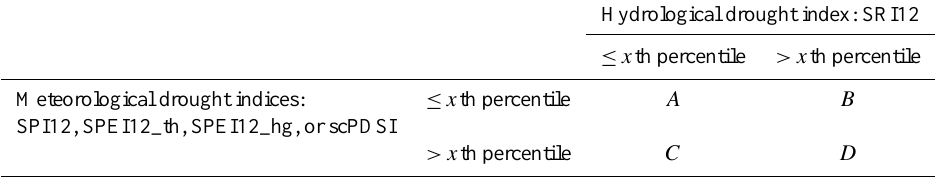
Table 4. Schematic of the 2 × 2 contingency table used to assess the ability of the meteorological indices to detect a hydrological drought event: A denotes the number of “hits”, B the number of “false alarms”, C the number of “misses”, and D the number of “correct non-events”.